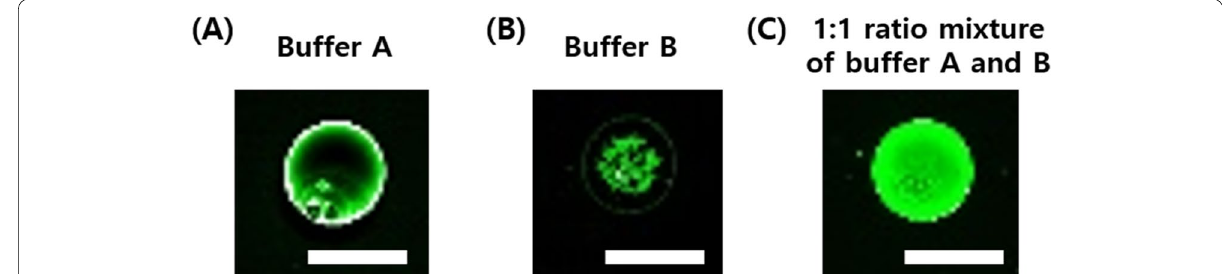
Fig. 2 Fluorescence scan image of fluorescent probe DNA immobilized on a COC chip to determine the optimal spotting buffer conditions. The scale bar is 500 μm